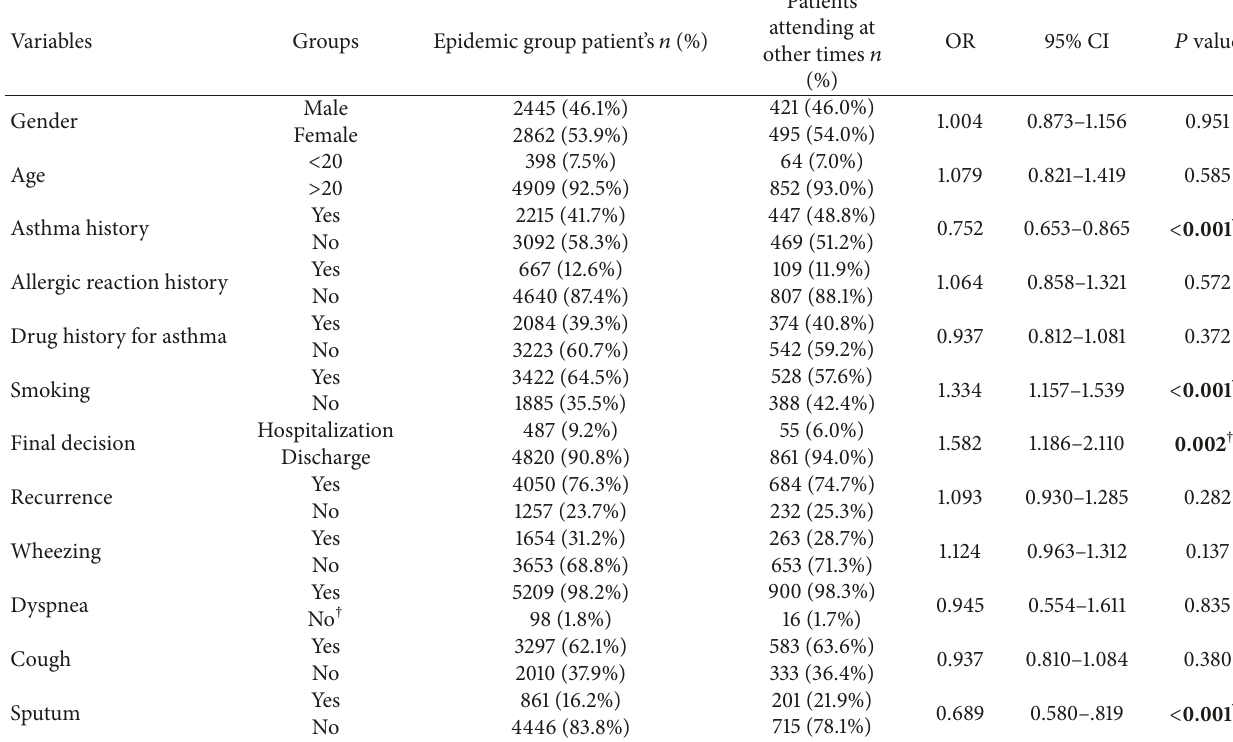
Table 1: A Comparison of the clinical and epidemiological characteristics of patients in the case and control group during